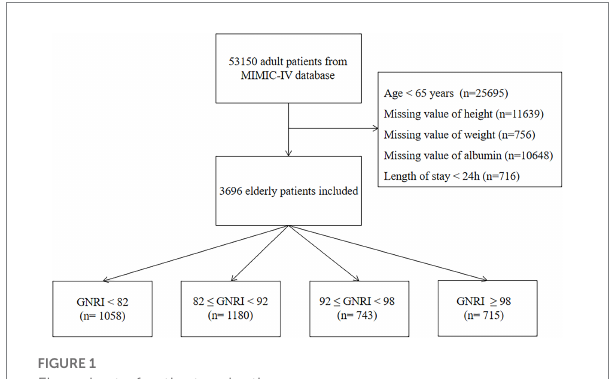
FIGURE 1 Flow chart of patients